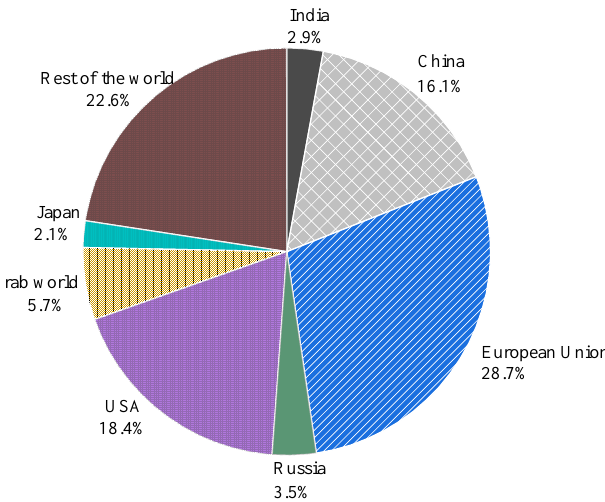
Figure 1. Economic loss due to corrosion.